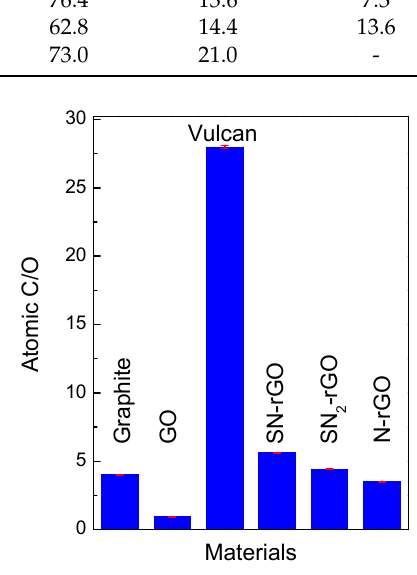
Figure 2. C/O ratio for all studied materials (blue) and their respective error bar (red).